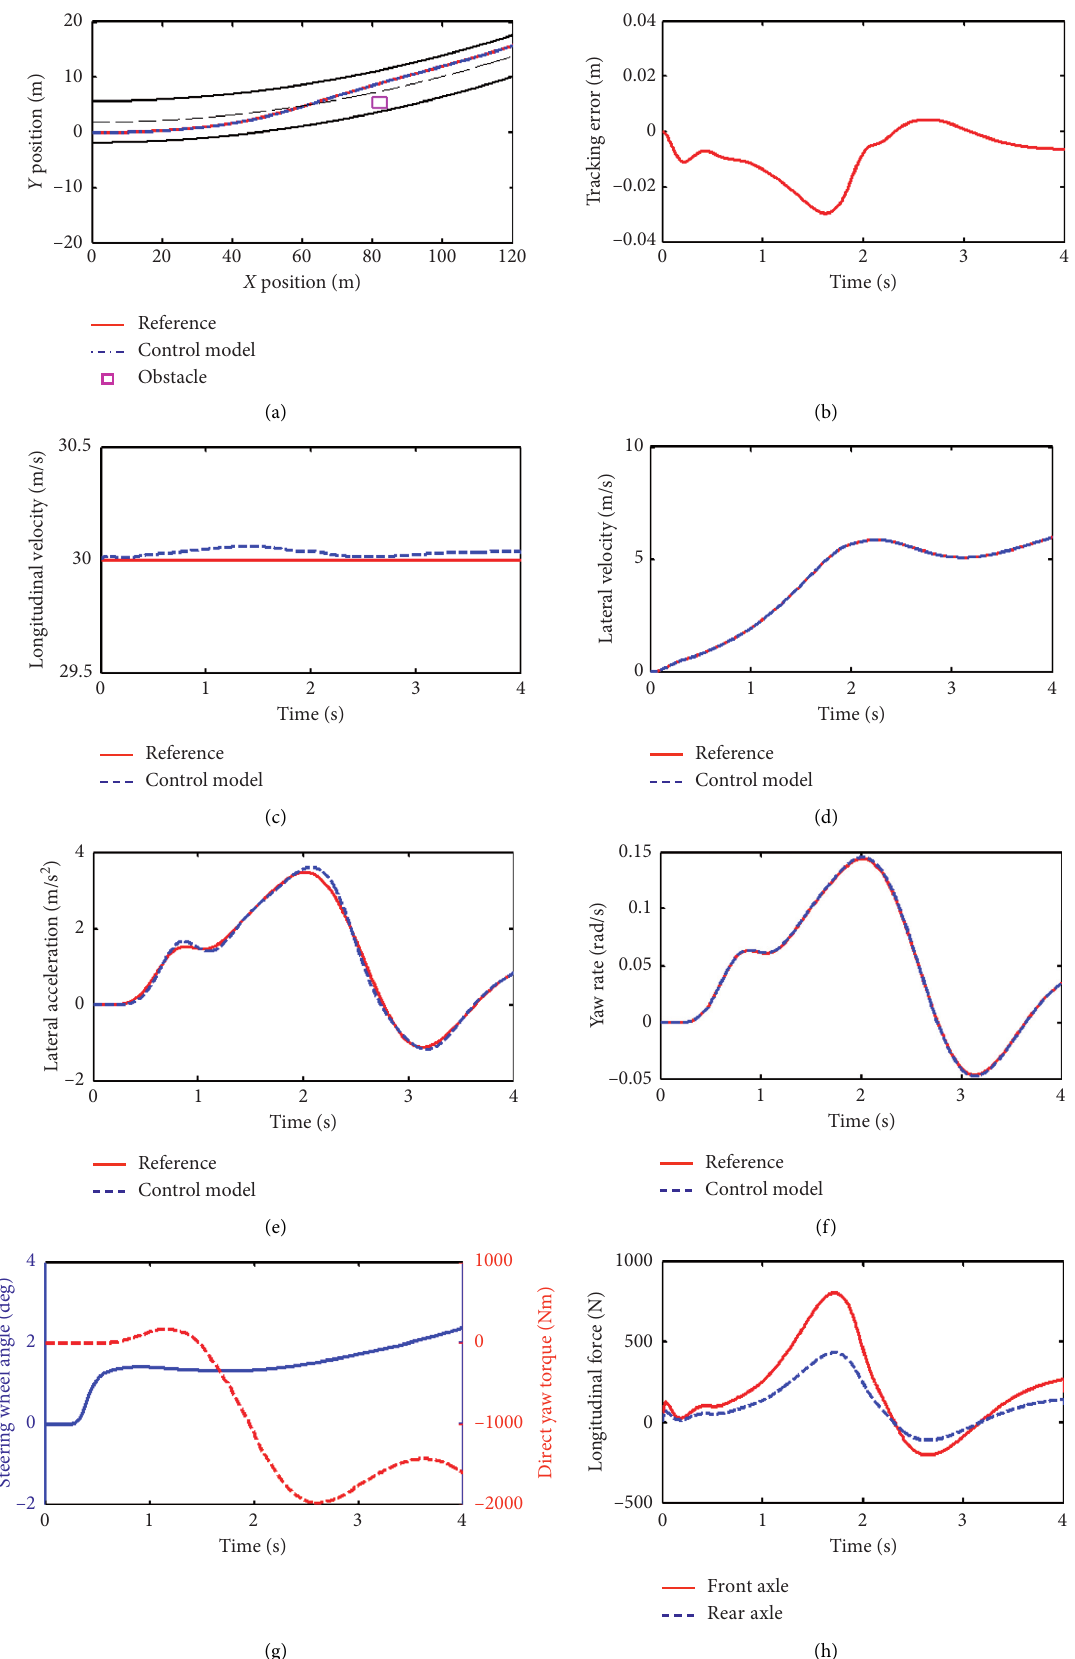
Figure 8: Control effects of specific modes for anticollision on a curved road. (a) Global path. (b) Tracking error. (c) Longitudinal velocity. (d) Lateral velocity. (e) Lateral acceleration. (f) Yaw rate. (g) Control inputs of AFS and DYC. (h) Control inputs of longitudinal